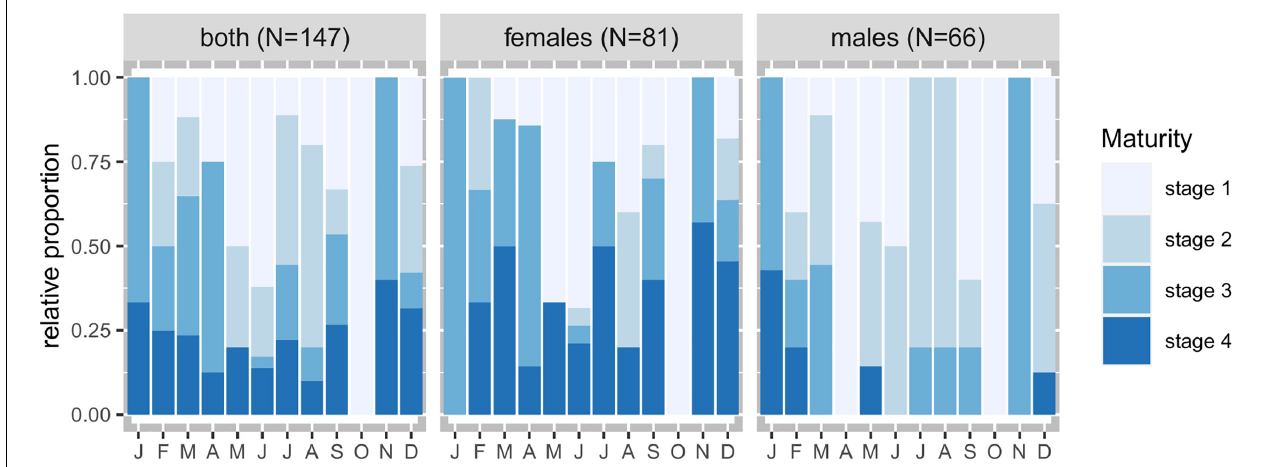
FIGURE 4 | Maturity stages relative proportions by sex and by month of Sphaerechinus granularis in Madeira archipelago.